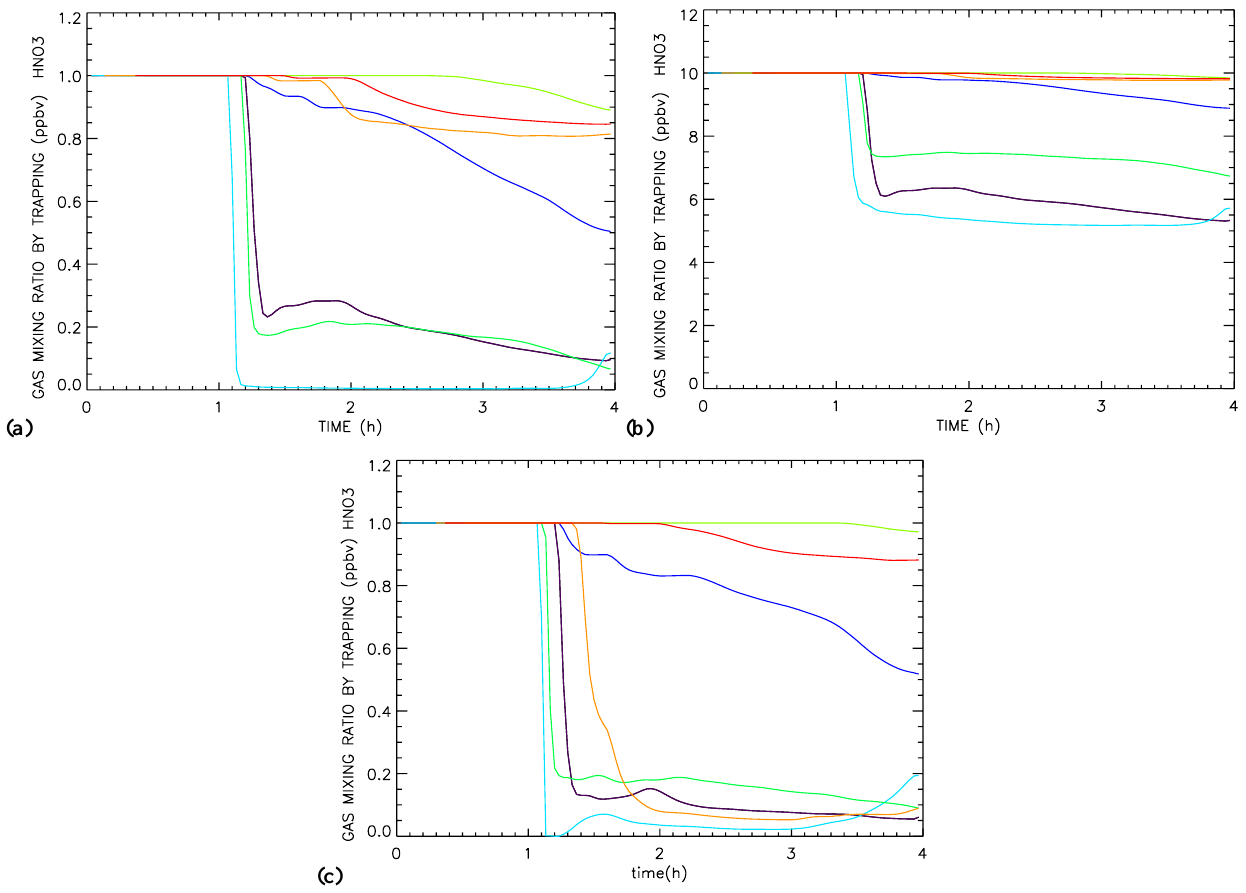
Fig. 13. Time evolution of the HNO 3 gas phase mixing ratio computed in the trapping theory assuming a constant total (gas+bulk) mixing ratio. (a) Time evolution along the trajectories of the REF simulation for a total mixing ratio of 1ppbv (b) Time evolution along the trajectories of the REF simulation for a total mixing ratio of 10ppbv, (c) same as (a) along trajectories of the RUN1M